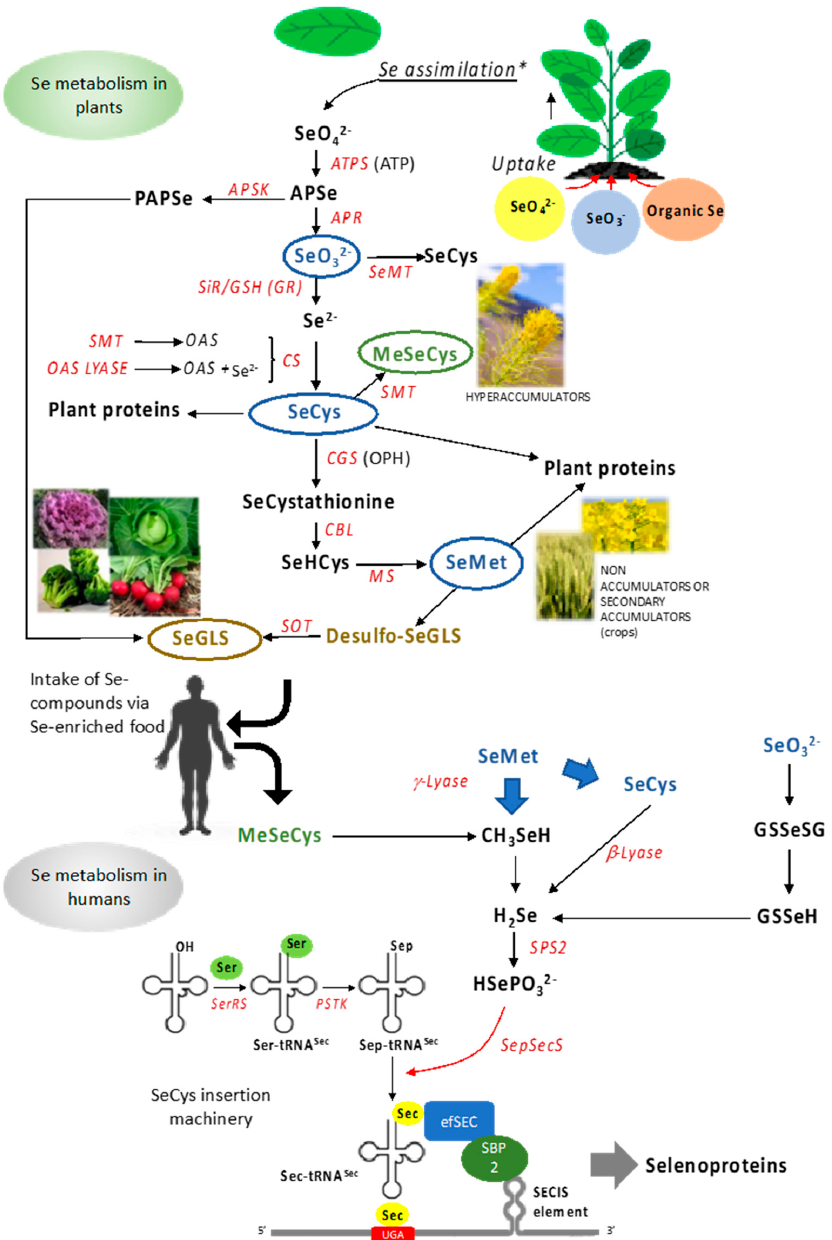
Figure 1. Flux of Se compounds from plants to humans. Top: metabolic pathway of Se in plants. Bottom: assimilation of Se compounds in human cells and specific mechanism of SeCys insertion in selenoproteins. In blue are compounds produced by all plants, in green are those specifically produced by Se-hyperaccumulators and in yellow are those generated in plant species belonging to Brassicaceae, Capparidaceae, and Euphorbiaceae families. Enzymes are indicated in red. All acronimous are given in the text.